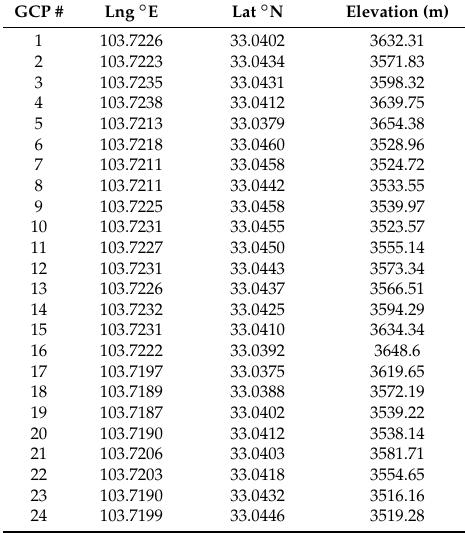
Table A2. The measured three-dimensional (3D) coordinates of Ground Control Points (GCPs) for AT